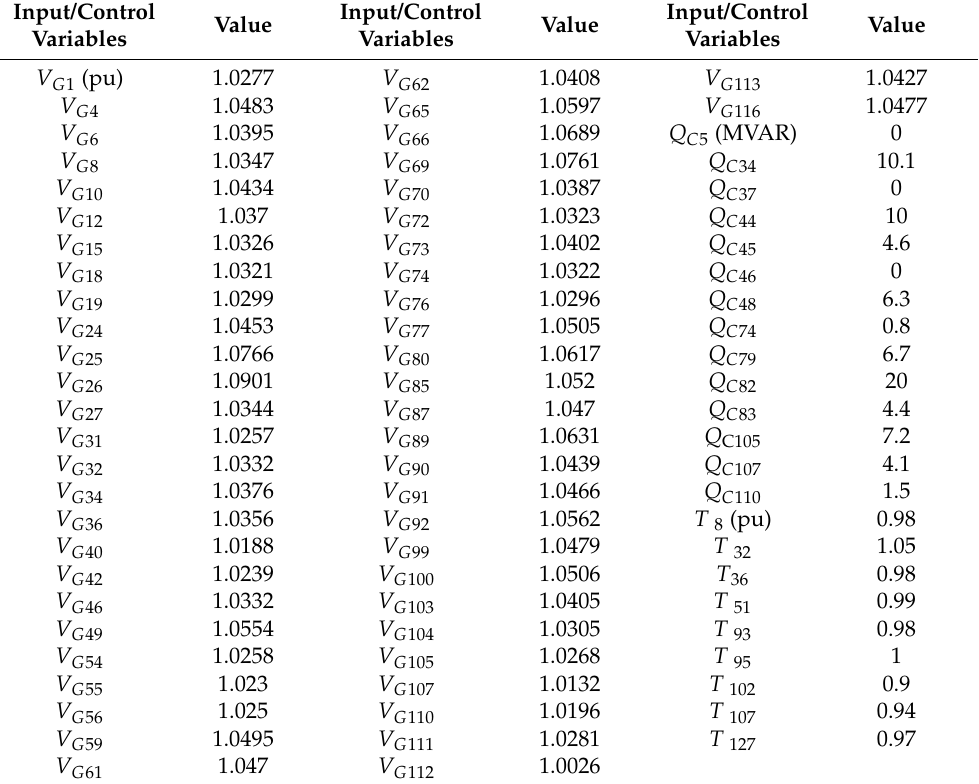
Table A6. Optimal solution obtained by ICOA for TPL objective of the IEEE 118-bus power system with the case of discrete variables.